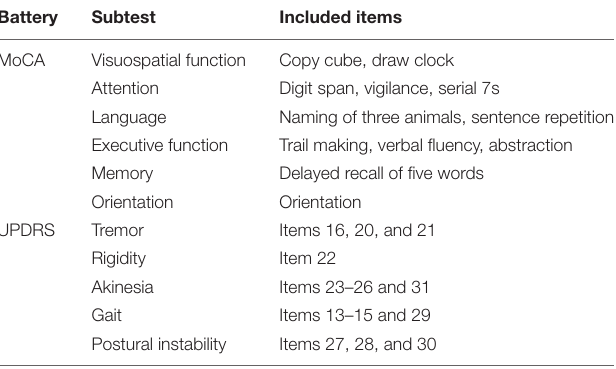
TABLE 1 | Test items inclueded in the six MoCA subtests and motor subscores.